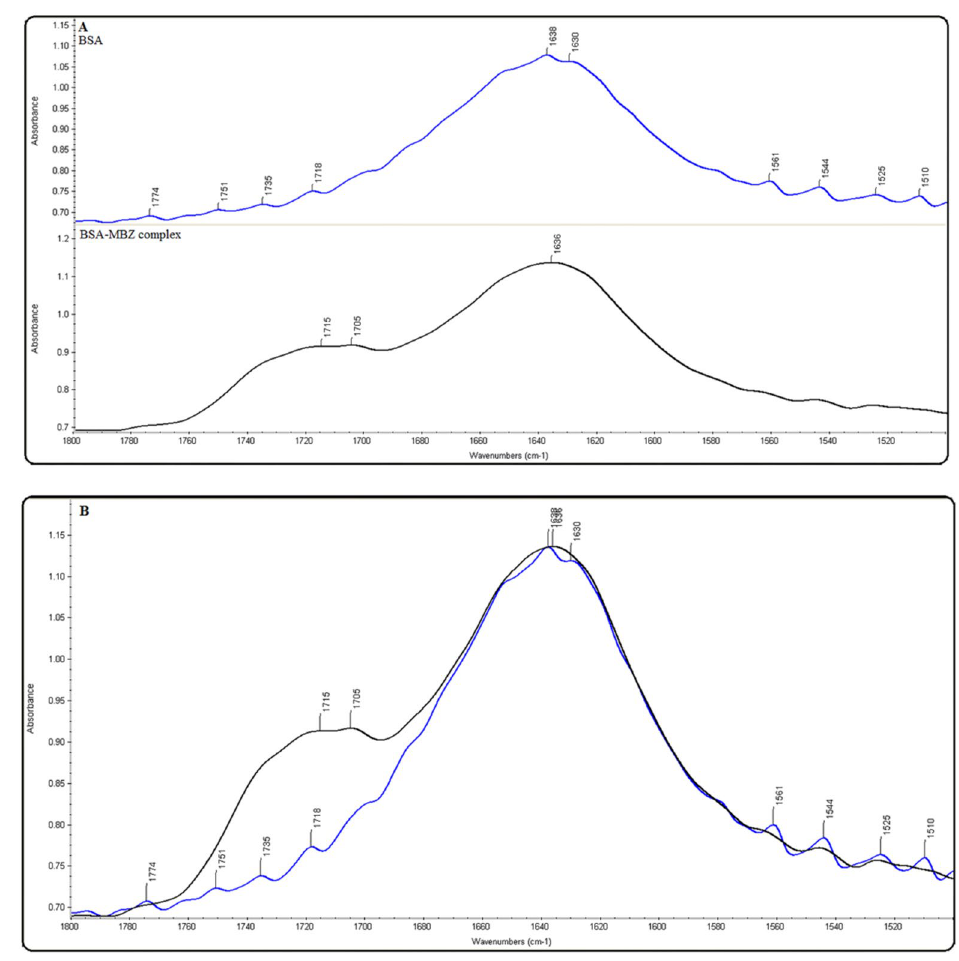
Figure 10. Free BSA and BSA-MBZ complex FTIR spectra at 298 K at pH